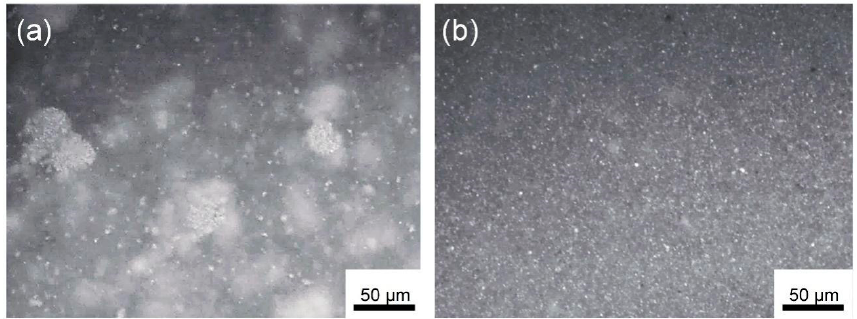
Figure 2. Optical microscope images of ( a ) PS film doped with agg -Al NPs and ( b ) PS film doped with iso -NPs@PS.